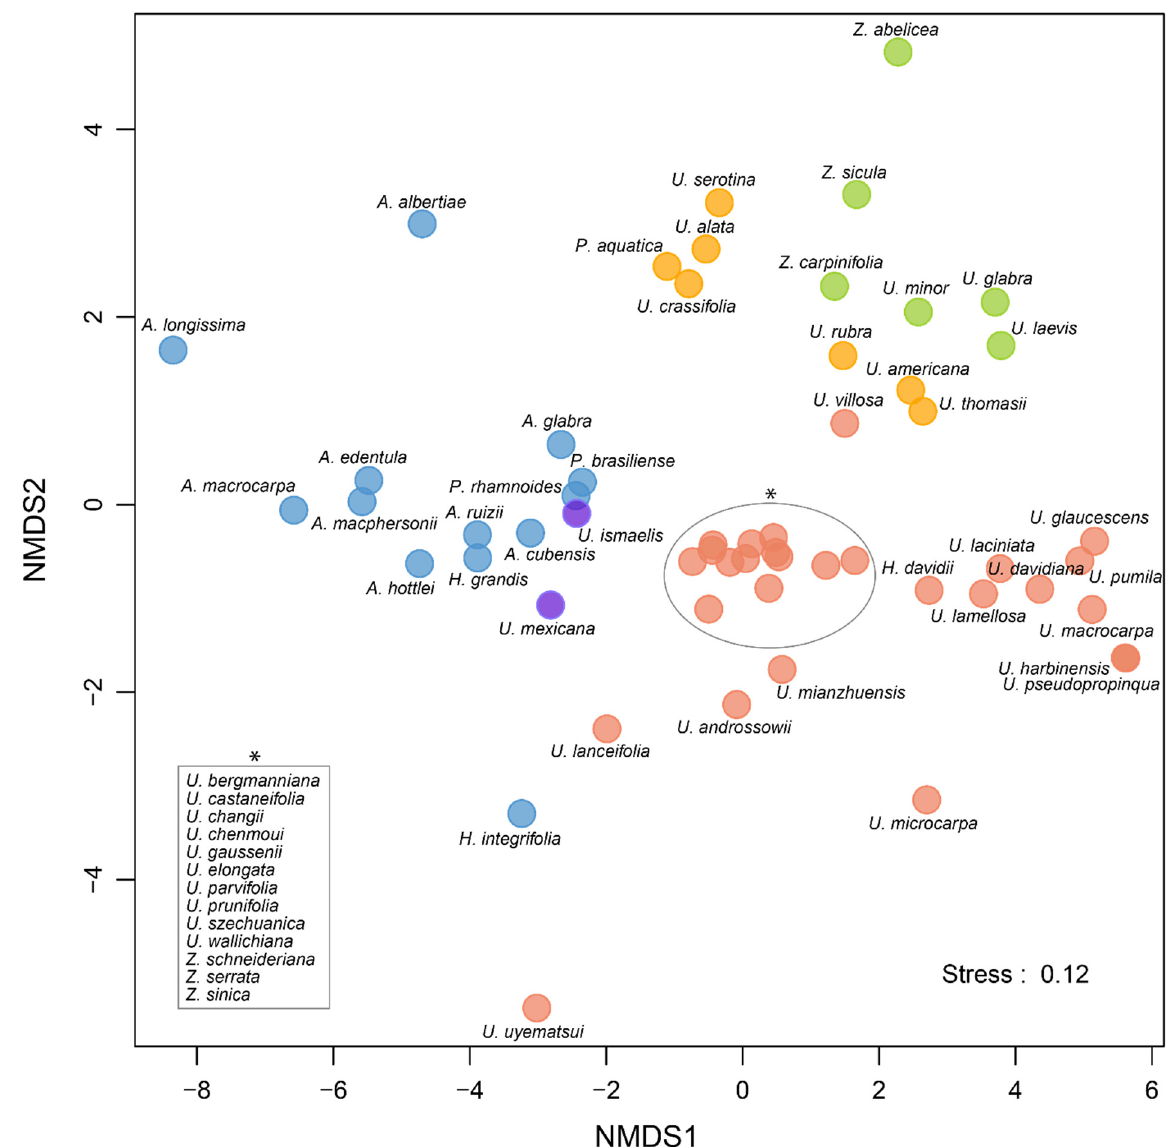
Figure 5. Nonmetric multidimensional scaling (NMDS) ordination plot representing the (macro)climatic similarities between species of the Ulmaceae family. A total of 19 climatic variables were included in the analysis (see Material and Methods). Species appearing close together in the plot share similar macroclimatic preferences. The species are divided into the following groups: tropical clade (blue), temperate clade divided further in Mesoamerica (purple), North America (yellow), Europe (green), and Asia (red).